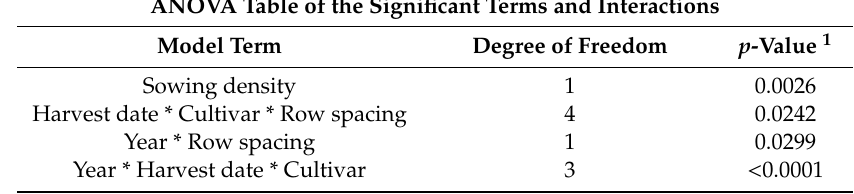
Figure 4. Carthamidin yield (kg ha − 1 ) for the two years (( a ) 2017 and ( b ) 2018) and the eight different treatments (German and Chinese cultivar (C1 and C2), row spacing of 12 and 33 cm (S1 and S2), and sowing densities of 40 and 75 plants m − 2 (D1 and D2) of the five harvests (Harvest 1–5) (DAS, days after sowing) represented as mean values ± standard error. Table 8. ANOVA table of the significant terms and interactions in carthamidin yield.